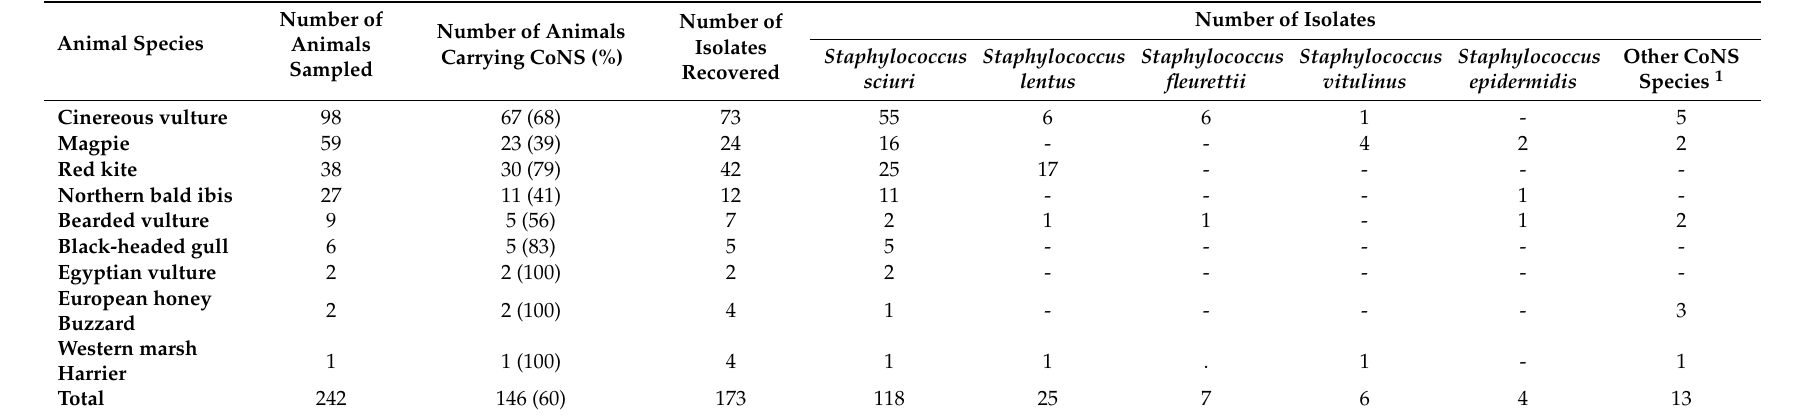
Table 1. Number of animals sampled, and diversity of coagulase-negative staphylococci (CoNS) species detected among wild birds. Animal